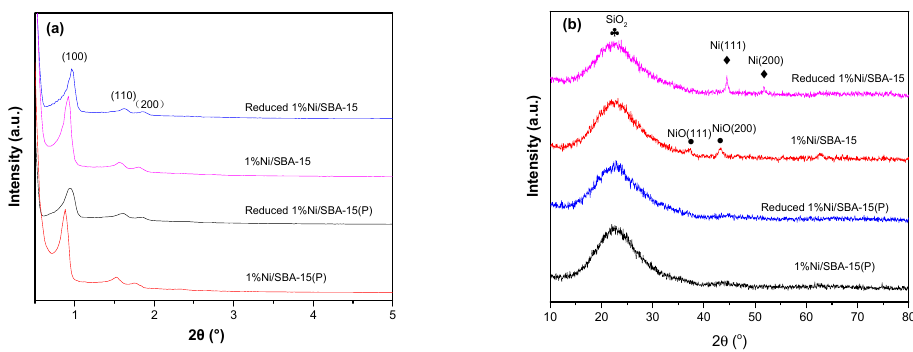
Figure 3. ( a ) Small-angle and ( b ) wide-angle XRD patterns of fresh and reduced catalysts.